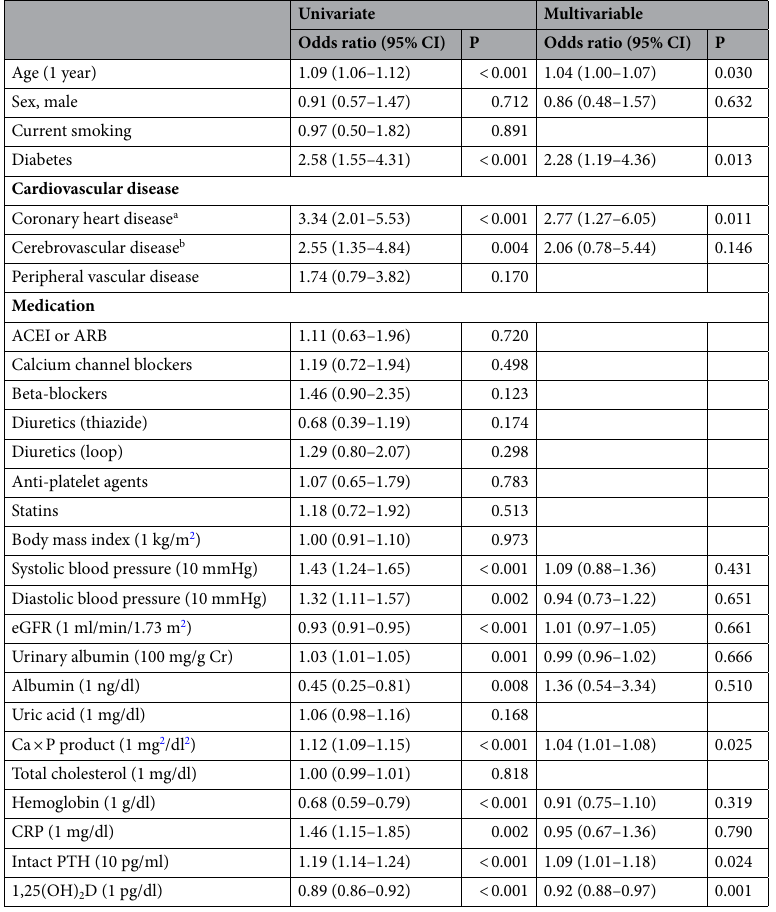
Table 3. Univariate and multivariable analyses for variables associated with mitral valve calcification in the study population (n = 513). Data are presented as odds ratio and 95% confidence interval (CI). a Coronary heart disease is defined as a history of coronary artery bypass surgery or percutaneous transluminal coronary angioplasty. b Cerebrovascular disease is defined as a history of stroke or transient ischemic attack. ACEI angiotensin-converting enzyme inhibitors, ARB angiotensin receptor blockers, Ca × P product, calcium × phosphorus product, CKD chronic kidney disease, CRP C-reactive protein, eGFR estimated glomerular filtration rate, PTH parathyroid hormone, 1,25(OH) 2 D 1,25-dihydroxyvitamin